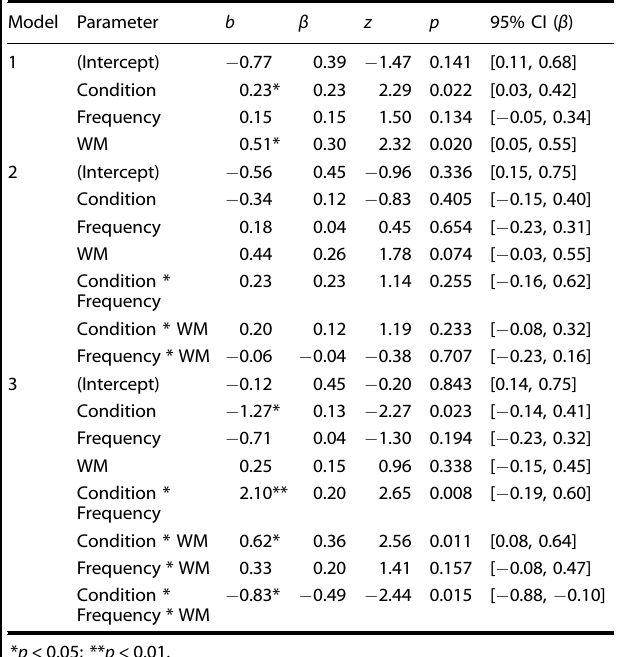
Fig. 1 Experiment procedure. Top panel : Example trials of the visual search task during the fi rst three weeks. The presentation ratio of High Frequency: Low Frequency was 15:1. Bottom panel : Procedure of the associative learning task, including the initial learning (left panel), the retrieval/restudy practice (middle panel), and the fi nal test (right panel). Table 1. Regression coef fi cients of the main effect model (Model 1), two-way interaction model (Model 2), and three-way interaction model (Model